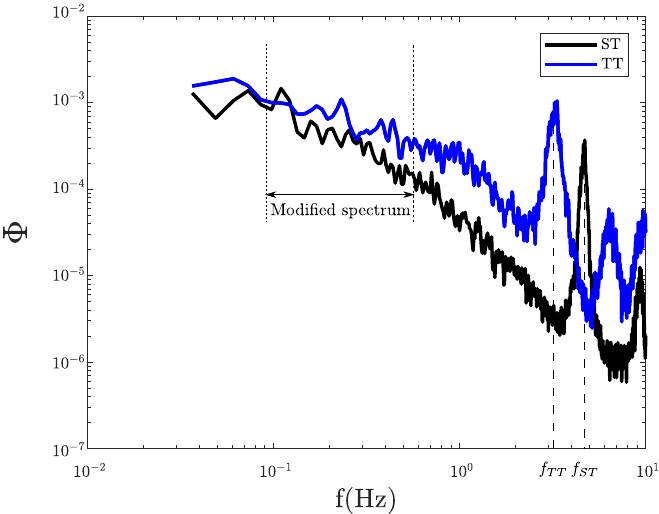
Figure 7. Voltage spectra for both study cases. The first peaks indicate the primary turbine rotational frequency for each case. At lower frequencies, surrounding flow effects are